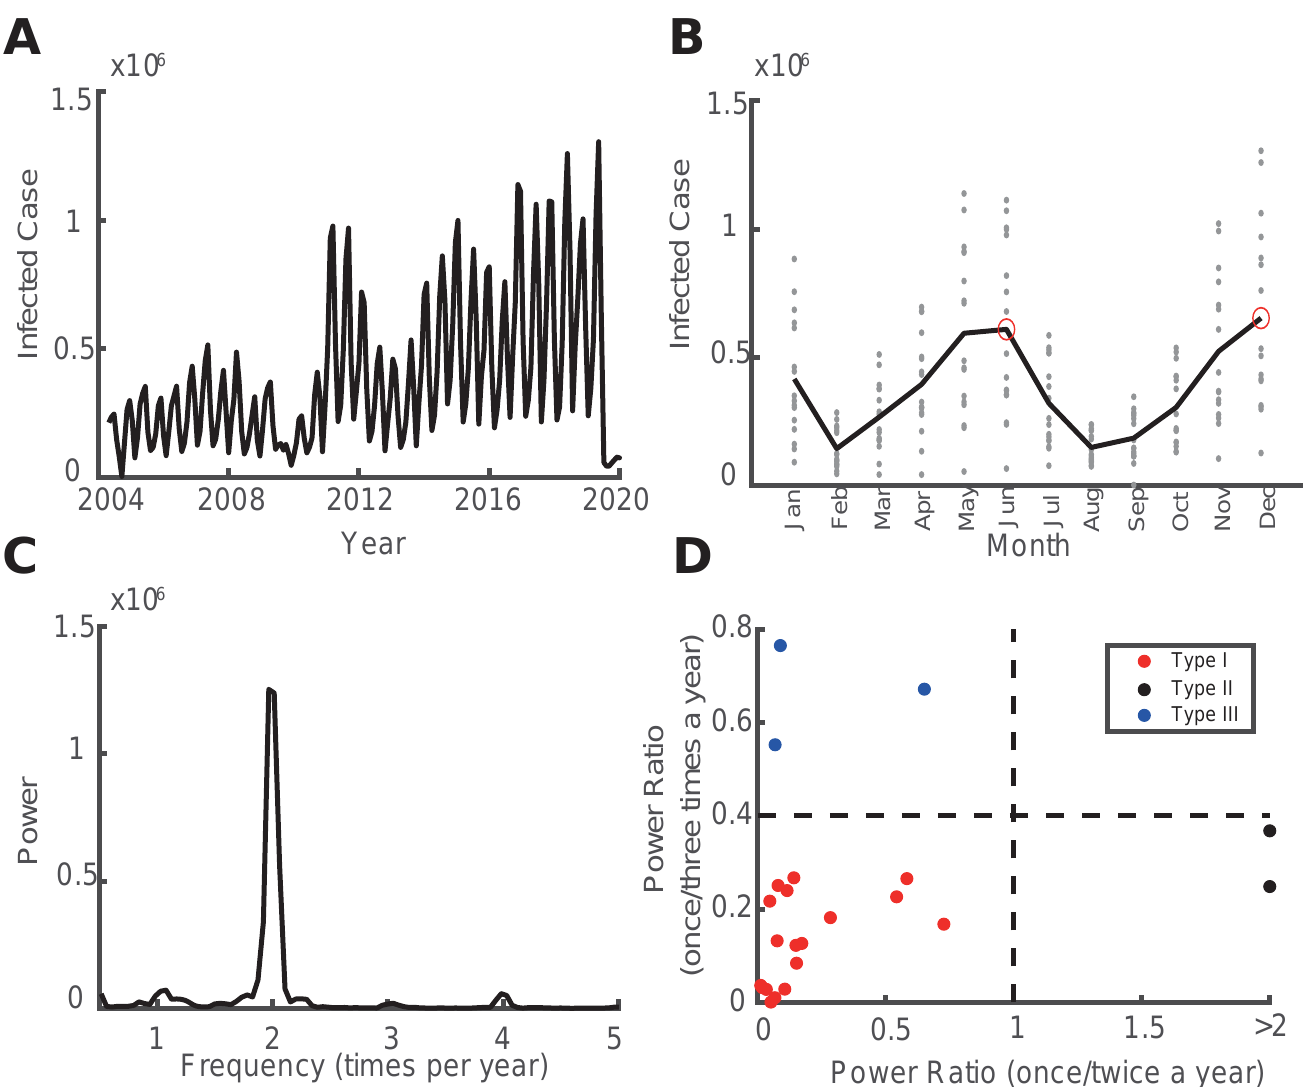
Fig 1. Representative infectious disease with clear oscillation pattern and three oscillatory types. Plot A shows an example time series of monthly infected cases from 2004 to 2020. In plot B, the grey dots indicate the number of infected cases every month in each year. The black curve is the average value for all years. The red circles are the peaks of the tuning curve. Plot C illustrates the power spectrum calculated from the data of left column. Plot D illustrates three clusters (denoted by red, black, and blue dots). The X-axis denotes the power ratio of occurrence between once a year and twice a year. The Y-axis denotes the power ratio of occurrence between once a year and three times a year. The dashed line is the criteria that separates them. The dots in the lower left depict diseases classified as Type I. The dots in the lower right corner depict diseases classified as Type II. The dots in the upper left corner are classified as Type III.